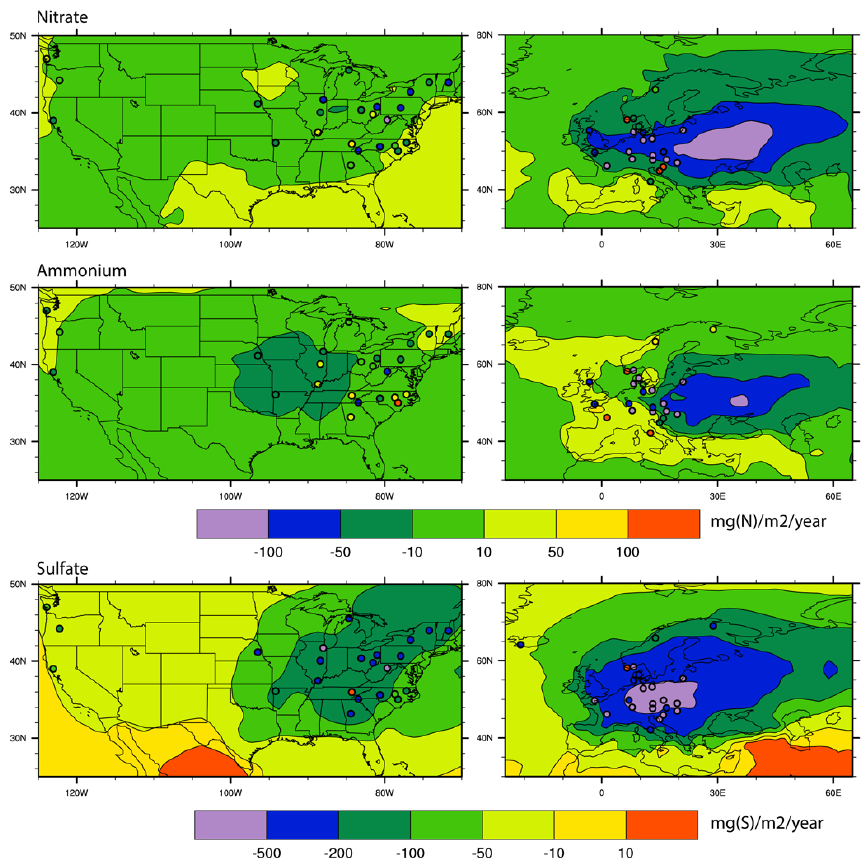
Fig. 3. Change in deposition (2000–1980) over the NADP (left column) and EMEP (right column) networks. Top row is for nitrate (mg(N)m − 2 yr − 1 ), middle row is for ammonium (mg(N)m − 2 yr − 1 ), and bottom row is for sulfate (mg(S)m − 2 yr − 1 ). Contours are the MMM results, filled circles are the